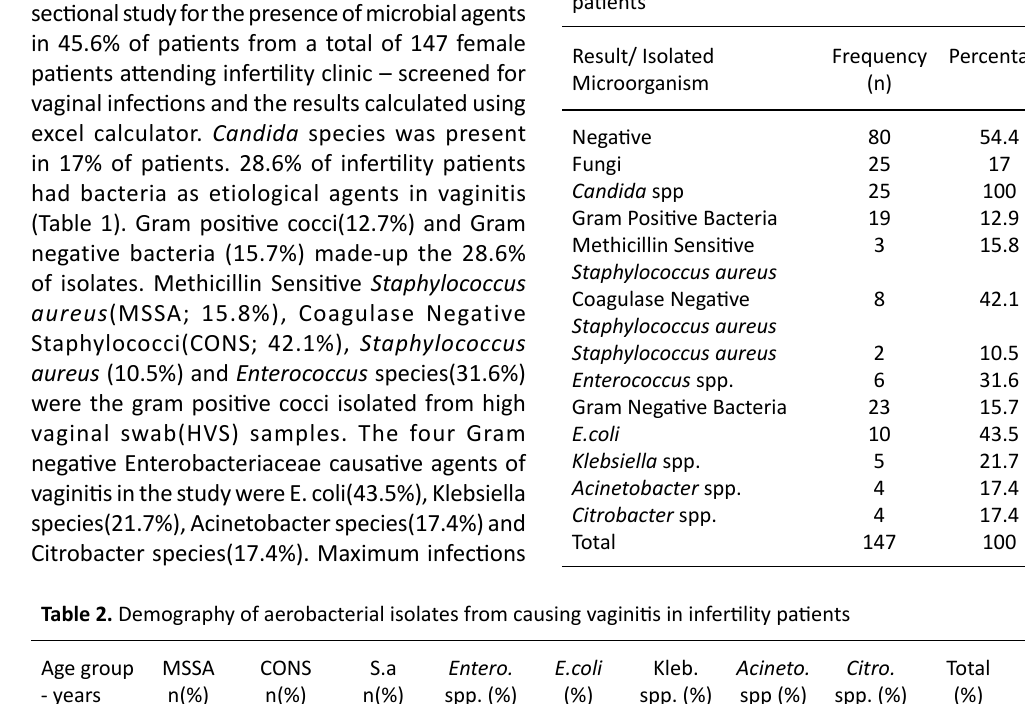
table 1. Microbial etiology in HVS samples of infertility